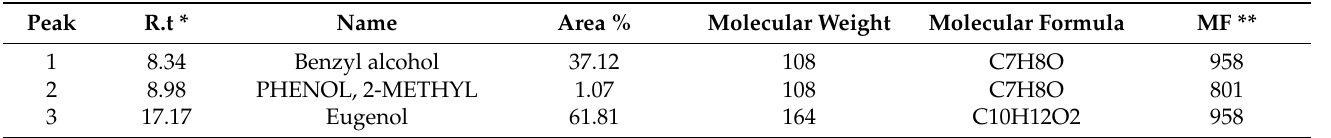
Table 5. The phytochemical composition of clove essential oil by